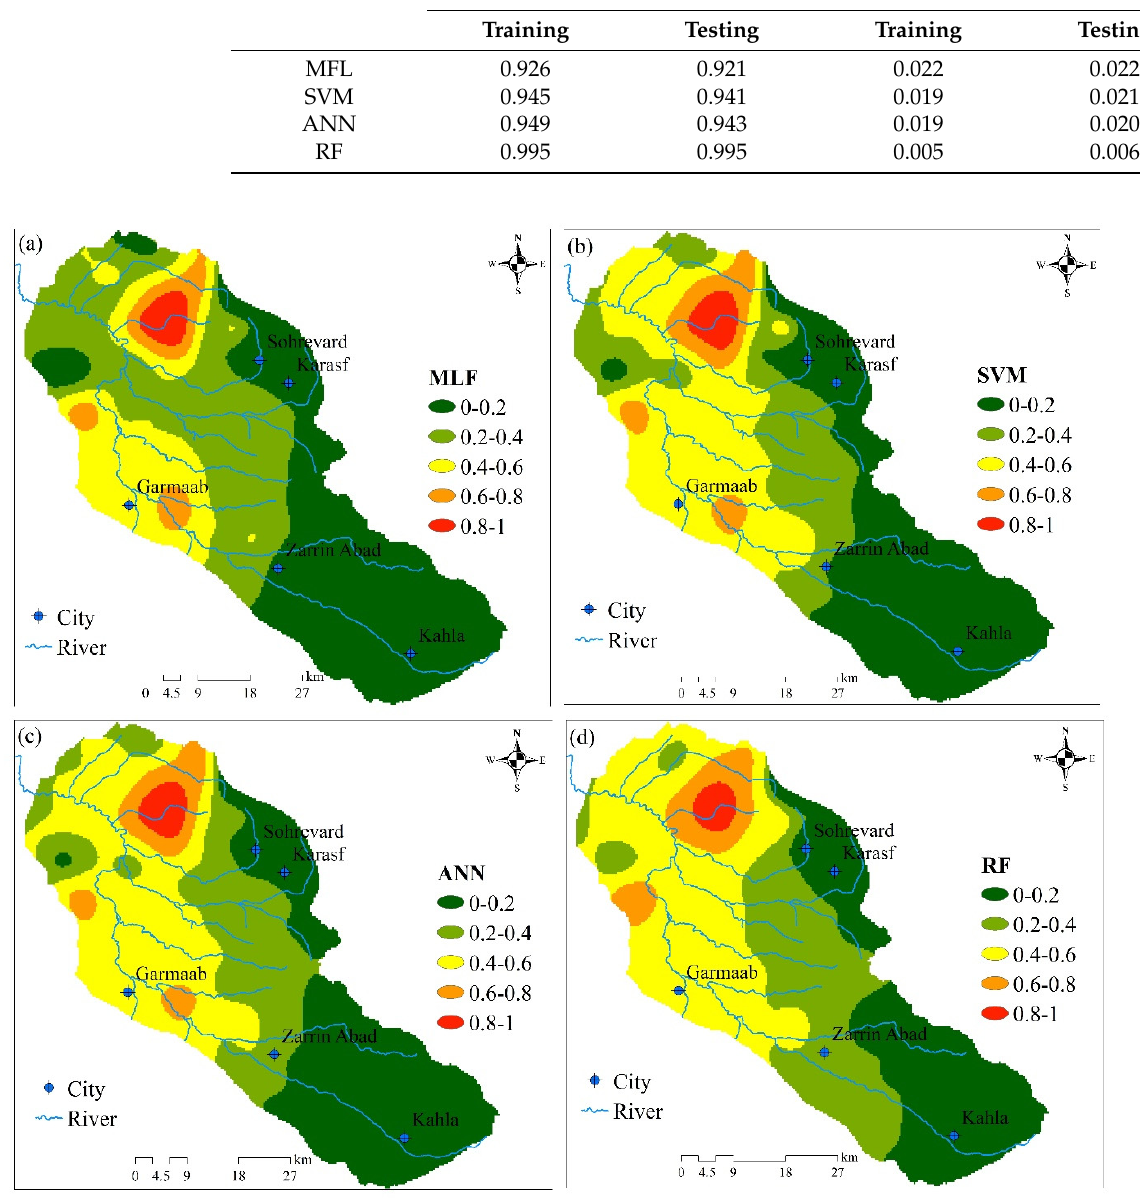
Figure 7. Spatial distribution of AI-based water quality index: ( a ) MFL; ( b ) SVM; ( c ) ANN; ( d ) RF.